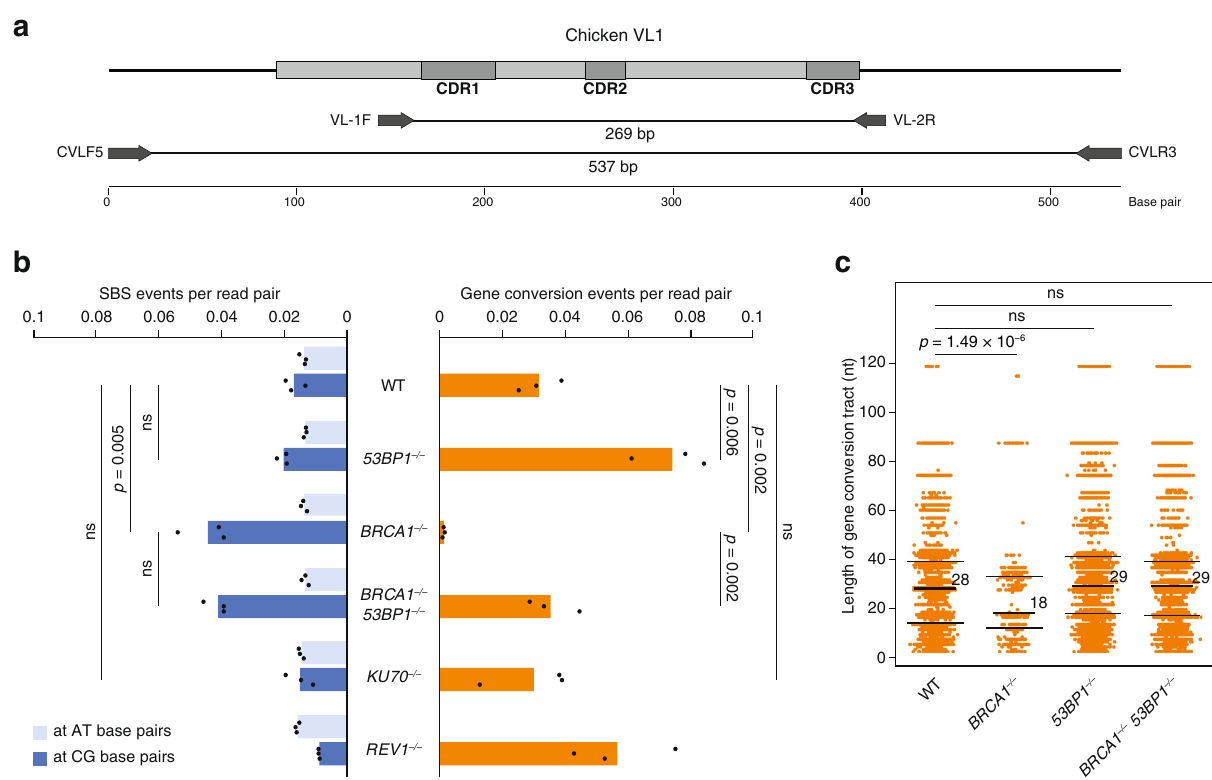
Fig. 4 53BP1 suppresses gene conversion in the absence of BRCA1. a Schematic map of the rearranged chicken immunoglobulin VL1 gene. The coding region is shown in grey, darker grey boxes indicate the hypervariable complementarity-determining regions (CDR). Primer pairs for an initial genomic PCR reaction (CVLF5 and CVLR3) and a subsequent nested indexed PCR (VL-1F and VL-2R) are shown. b SBS and gene conversion events detected in cell populations derived from individual DT40 cell clones of the indicated genotypes that were cultured for 40 days, presented as the number of mutation events per total number of sequenced read pairs in the same sample. Detected point mutation (SBS) events at AT or CG base pairs are shown separately. Bars show means, individual values of 3 parallel cell clones are indicated with black markers. The signi fi cance of tested differences is shown (unpaired two- sided t -test, ns not signi fi cant). c The maximum possible length of each individual gene conversion tract in sequence reads derived from cell populations of the indicated genotypes. The median, upper and lower quartiles are shown, the indicated statistical differences were calculated with the Wilcoxon rank- sum test. Source data are provided as a Source Data fi